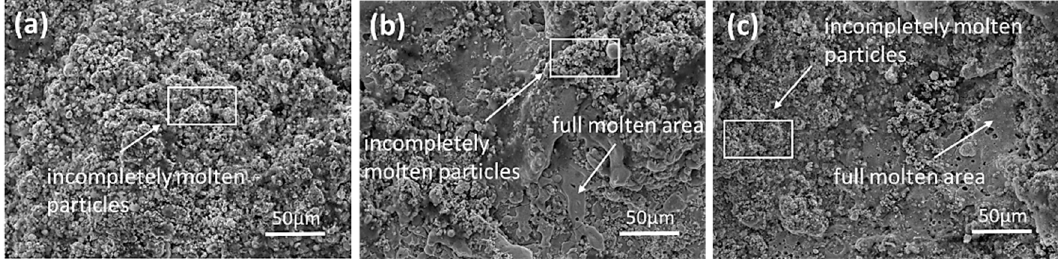
Figure 2. Surface morphology of MoSi 2 -ZrB 2 coatings: ( a ) mz40, ( b ) mz43 and ( c ) mz45.